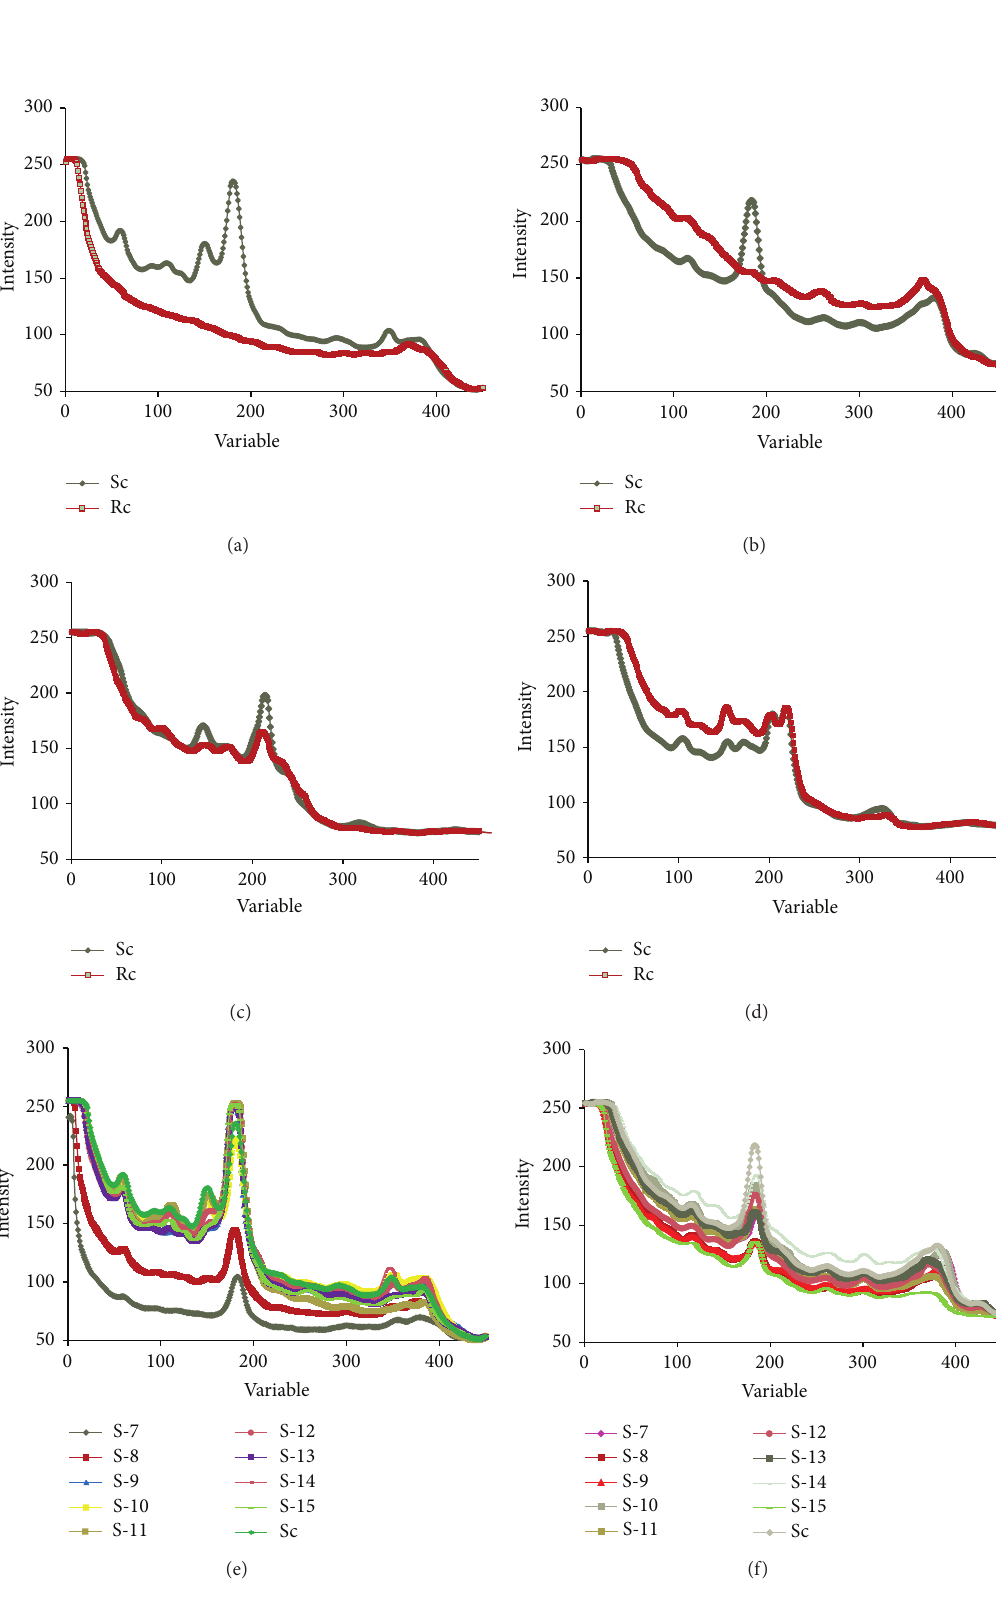
Figure 3: Phenolic profiles of shoot and root control samples for ZP 434 (a, c) and ZP 704 (b, d) hybrids obtained in CS2 and CS1, respectively, and shootsamples of ZP434 (e)and ZP704 (f)hybrids treated with brassinosteroidtypeof phytohormonein concentration of5.2 × 10 −7 –5.2 × 10 −15 M. Labels on score plot correspond to those in Table